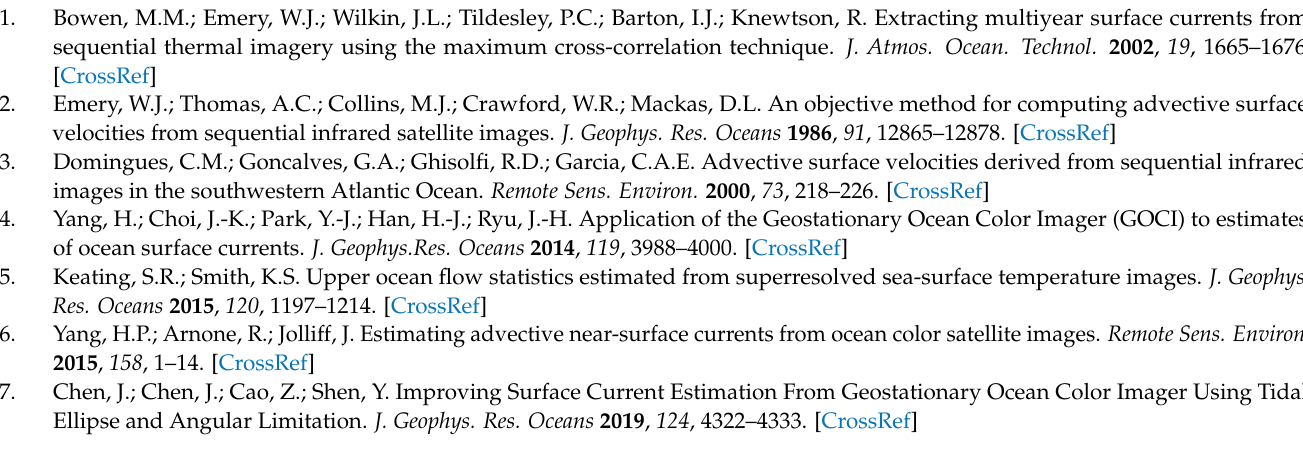
10.3390/rs14010014/s1, Figure S1. The hourly tidal heights at (122 ◦ E, 31 ◦ N) from 10 September to 15 October 2011. The start time for each case during spring and neap tides is marked by a bold gray line. The time is in Greenwich. Figure S2. The averaged velocity fields from model (left), MCC (middle), and MCC+MOI (right) for 12:00–14:00 UTC and 19:00–21:00 UTC on 30 September 2011 (during spring tide), overlying with the MITgcm model SST for 12:00 UTC (a), 14:00 UTC (b,c), 19:00 UTC (d), and 21:00 UTC (e,f). Figure S3. Same as Figure S2, but for 7 October 2011 (during neap tide). Figure S4. Same as Figure S2, but for 1 January 2012 (in winter). Figure S5. Same as Figure S2, but for 1 April 2012 (in spring). Figure S6. Same as Figure S2, but for 1 July 2012 (in summer). Figure S7. Same as Figure S2, but for 1 October 2011 (in autumn). Figure S8. Histograms of magnitude and angle differences between the MITgcm model velocities and those from either MCC or MCC+MOI on 30 September 2011 (during spring tide). For this histogram comparison, the total number of model vectors equals those estimated using MCC and MCC+MOI. Figure S9. Same as Figure S8, but for 7 October 2011 (during neap tide). Figure S10. Same as Figure S9, but for 1 January 2012 (in winter). Figure S11. Same as Figure S8, but for 1 April 2012 (in spring). Figure S12. Same as Figure S8, but for 1 July 2012 (in summer). Figure S13. Same as Figure S8, but for 1 October 2011 (in autumn). Figure S14. Surface currents from OSU model (top), MCC (middle) and MCC+MOI (bottom) for four GOCI image pairs at 03:30–04:30 UTC, 04:30–05:30 UTC, 05:30–06:30 UTC and 06:30–07:30 UTC on 5 April 2011. Figure S15. Same as Figure S14, but for 16 September 2013. Figure S16. Comparison of AME, AAE, and skill for velocities from the OSU model and from GOCI imagery using MCC and MCC+MOI for four different time intervals on 5 April 2011. Figure S17. Same as Figure S16, but